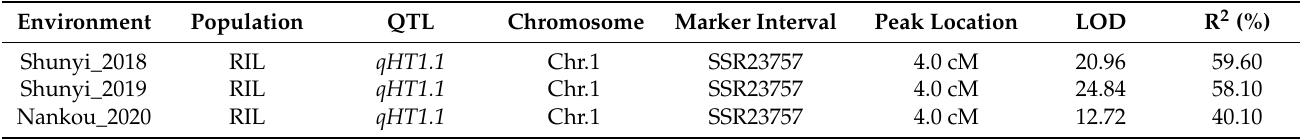
Figure 4. QTL mapping of heat tolerance in cucumber at adult stage. X -axis indicates the genetic position of each chromosome; Y -axis indicates the LOD value. The black, red, and orange lines indicate experiments conducted at Shunyi_2018, Shunyi_2019, and Nankou_2020. One QTL on chromosome 1 was repeatedly detected in 2018, 2019, and 2020. Table 2. QTL controlling heat tolerance in adult cucumber.